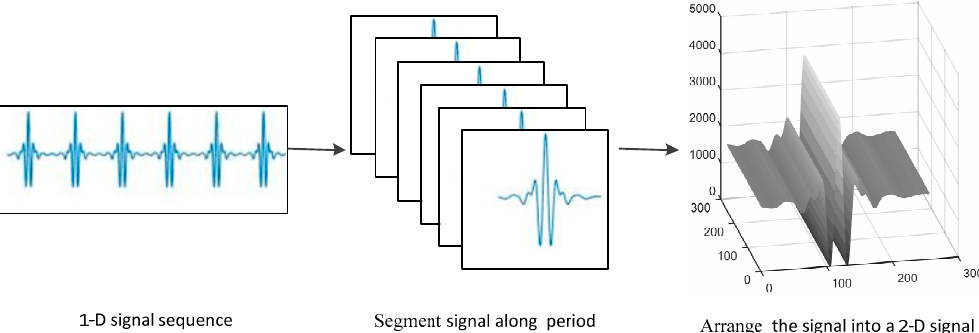
Figure 7. The process of two-dimensional expression of one-dimensional data.